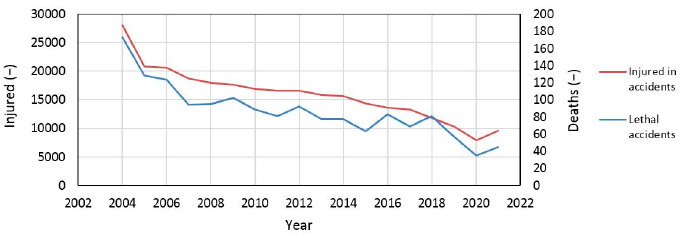
Figure 20. Accidents at work in individual farming in Poland, 2002–2021, data obtained from [66].